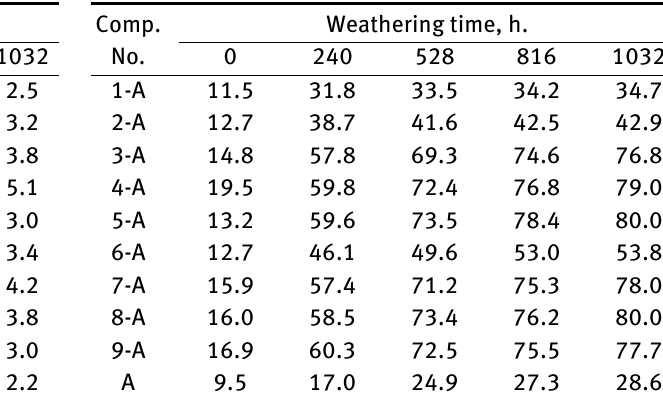
Table 4: Changes of the whiteness degree. of all composites as a function of weathering time